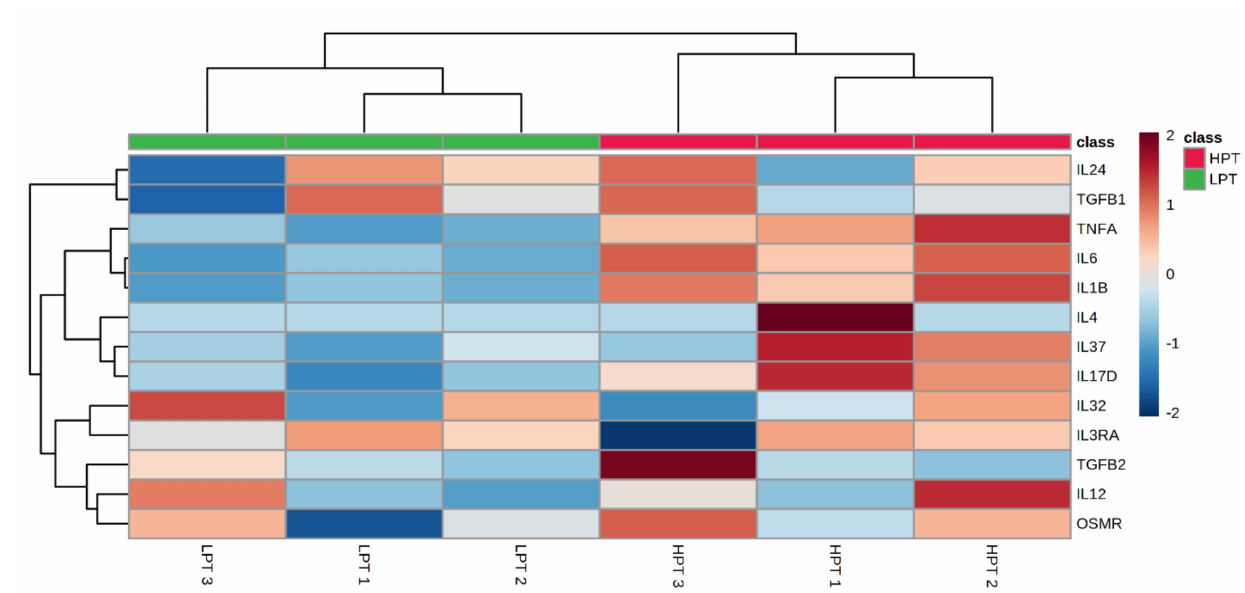
Figure 2. Dendrogram of differential expressed genes involved the pro-inflammatory cytokines. The log 10 (FPKM+1) value was clustered. Blue represents the low-level genes, and red represents the high-level genes. The color from blue to red represents that the gene expression level is higher and higher.